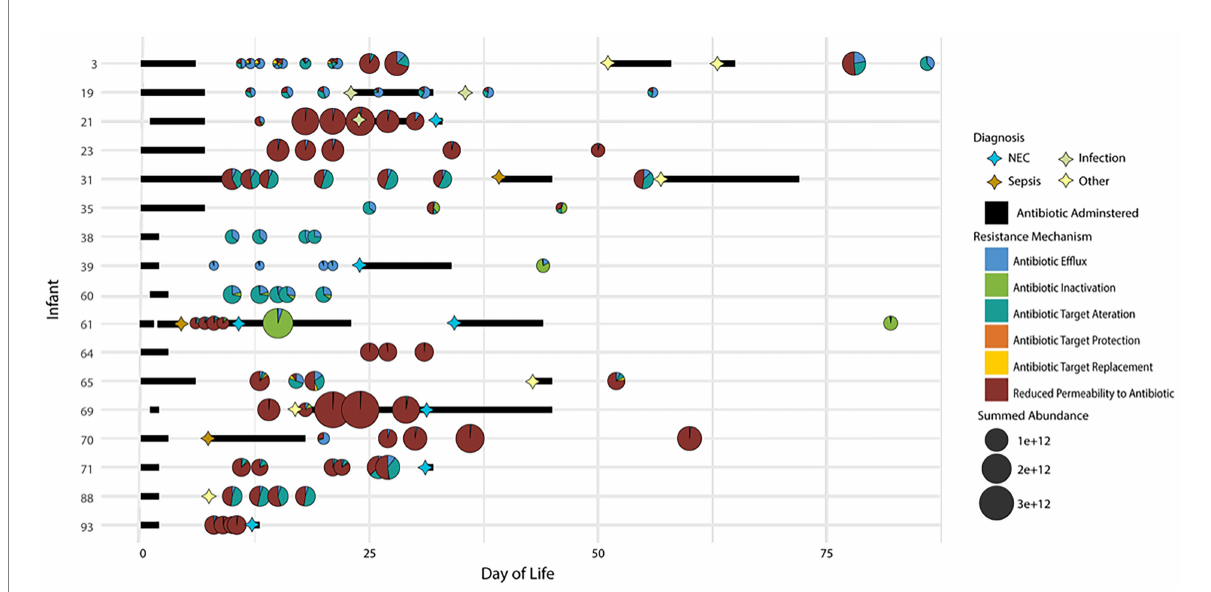
FIGURE 3 Distribution of antibiotic resistance orthologs (AROs) found in each sample for all 17 infants in the study. Samples are plotted based on time of collection (DOL) on the x-axis and by the infant on the y-axis. The size of the bubble indicated the summed ARO abundance in the sample. The pie charts indicate the contribution of each CARD database antibiotic resistance mechanism identified in the sample to the overall summed ARO abundance. Also plotted are markers indicating dates of disease diagnosis and bars to indicate periods of time when antibiotics were